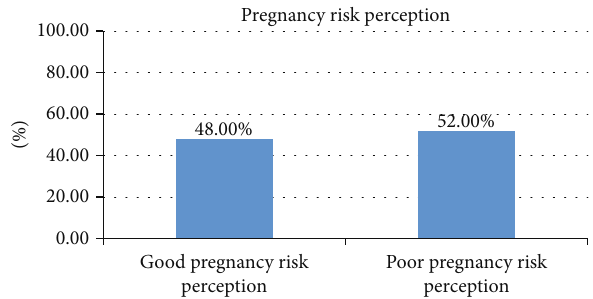
Figure 2: Perceived severity of pregnancy-related complications among pregnant women attending antenatal care at Jabi Tenhan District health centers in April 2021 ( n = 421 ).